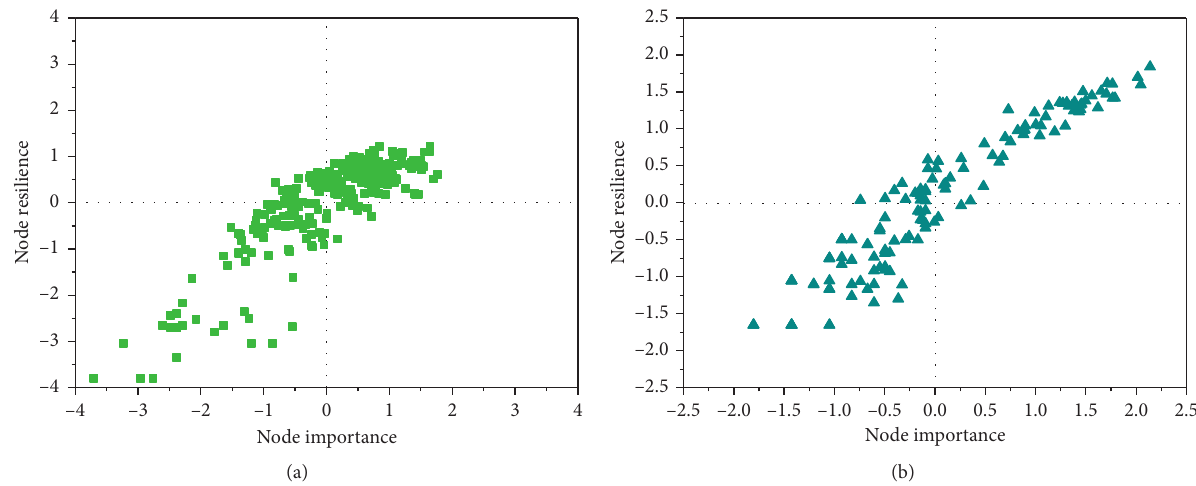
Figure 9: Matching of nodes importance and resilience. (a) Railway network. (b) Air transport network.